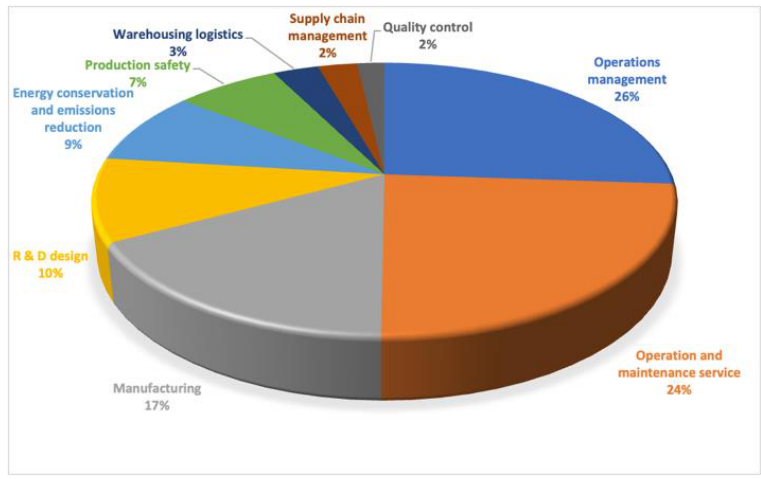
Figure 7. Distribution of APP types in the top ten platform industries in 2020.